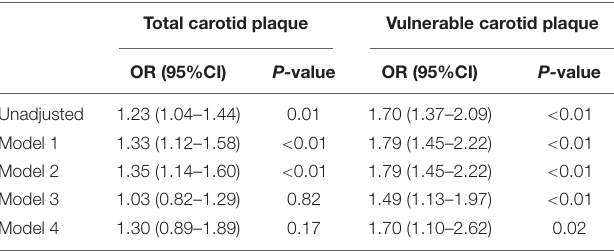
TABLE 3 | Multiple logistic regression analysis for the association between male sex and carotid plaque in a population at high risk of